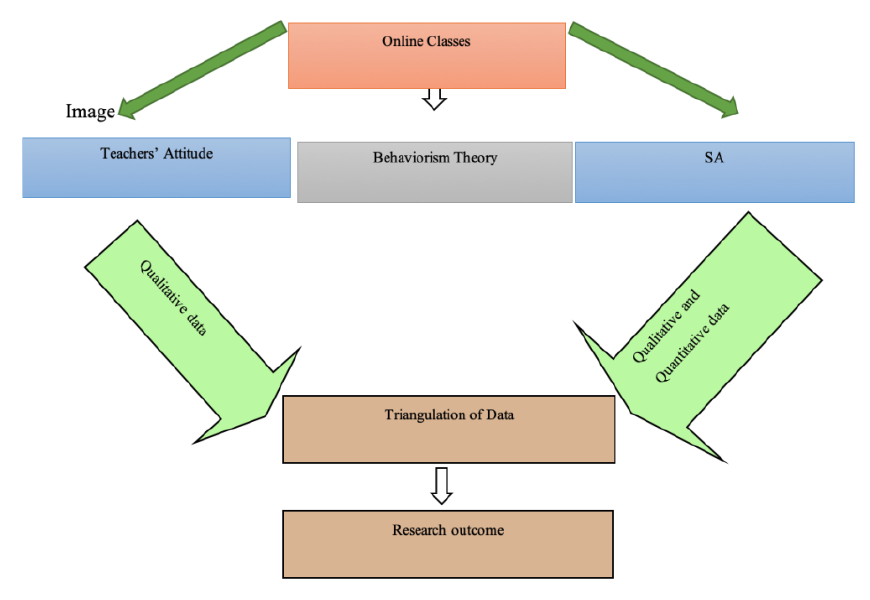
Figure 7: Research process for this study; Source: Self